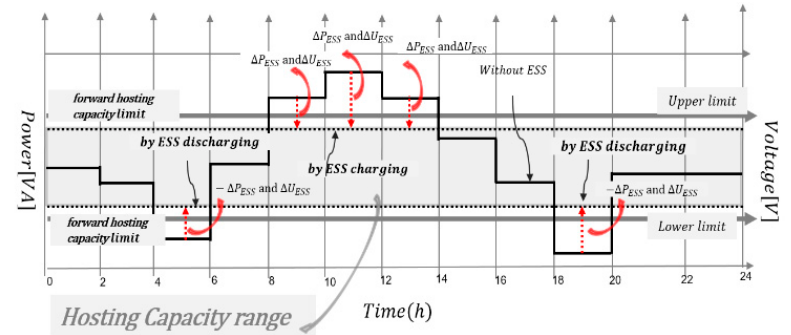
Figure 4. Operational concept of proposed method.